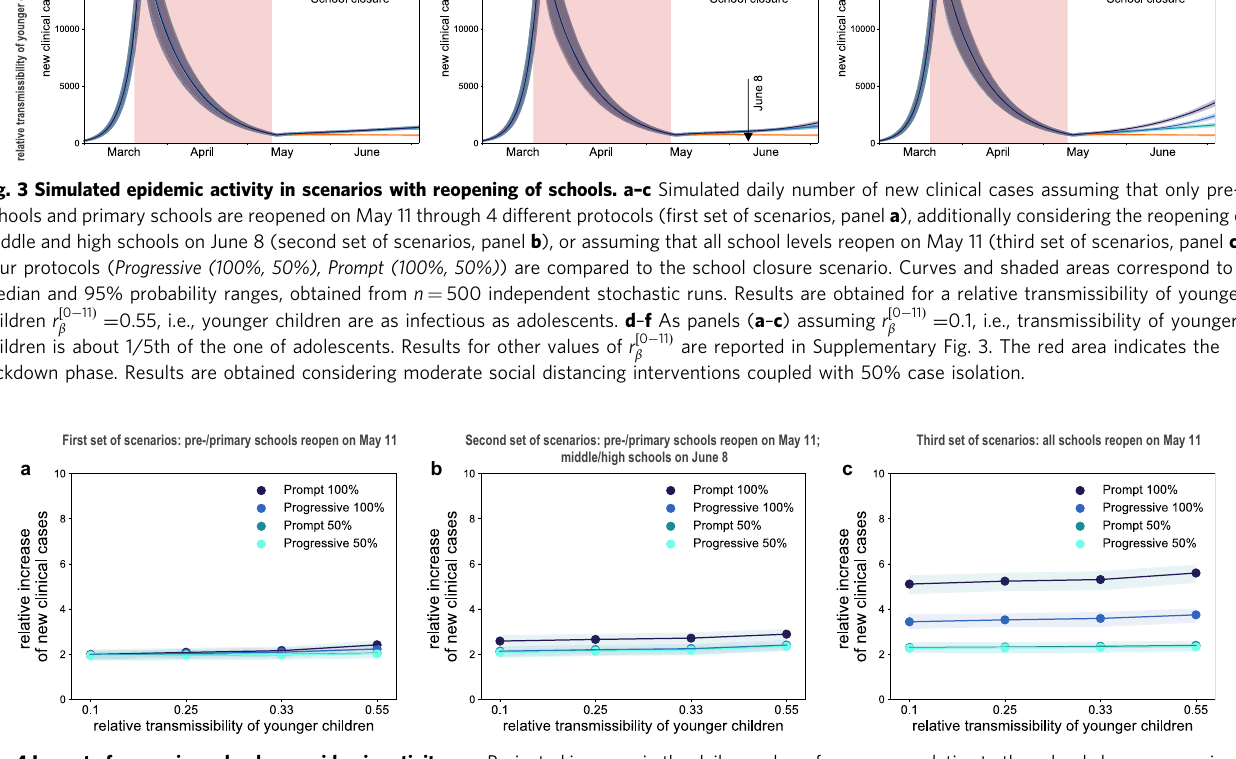
Fig. 4 Impact of reopening schools on epidemic activity. a – c Projected increase in the daily number of new cases relative to the school closure scenario on July 5 (start of summer holidays) as a function of the relative transmissibility of younger children, for different reopening protocols. Results are obtained considering moderate social distancing interventions coupled with 50% case isolation. Shaded areas correspond to 95% probability ranges around the median value, obtained from n = 500 independent stochastic